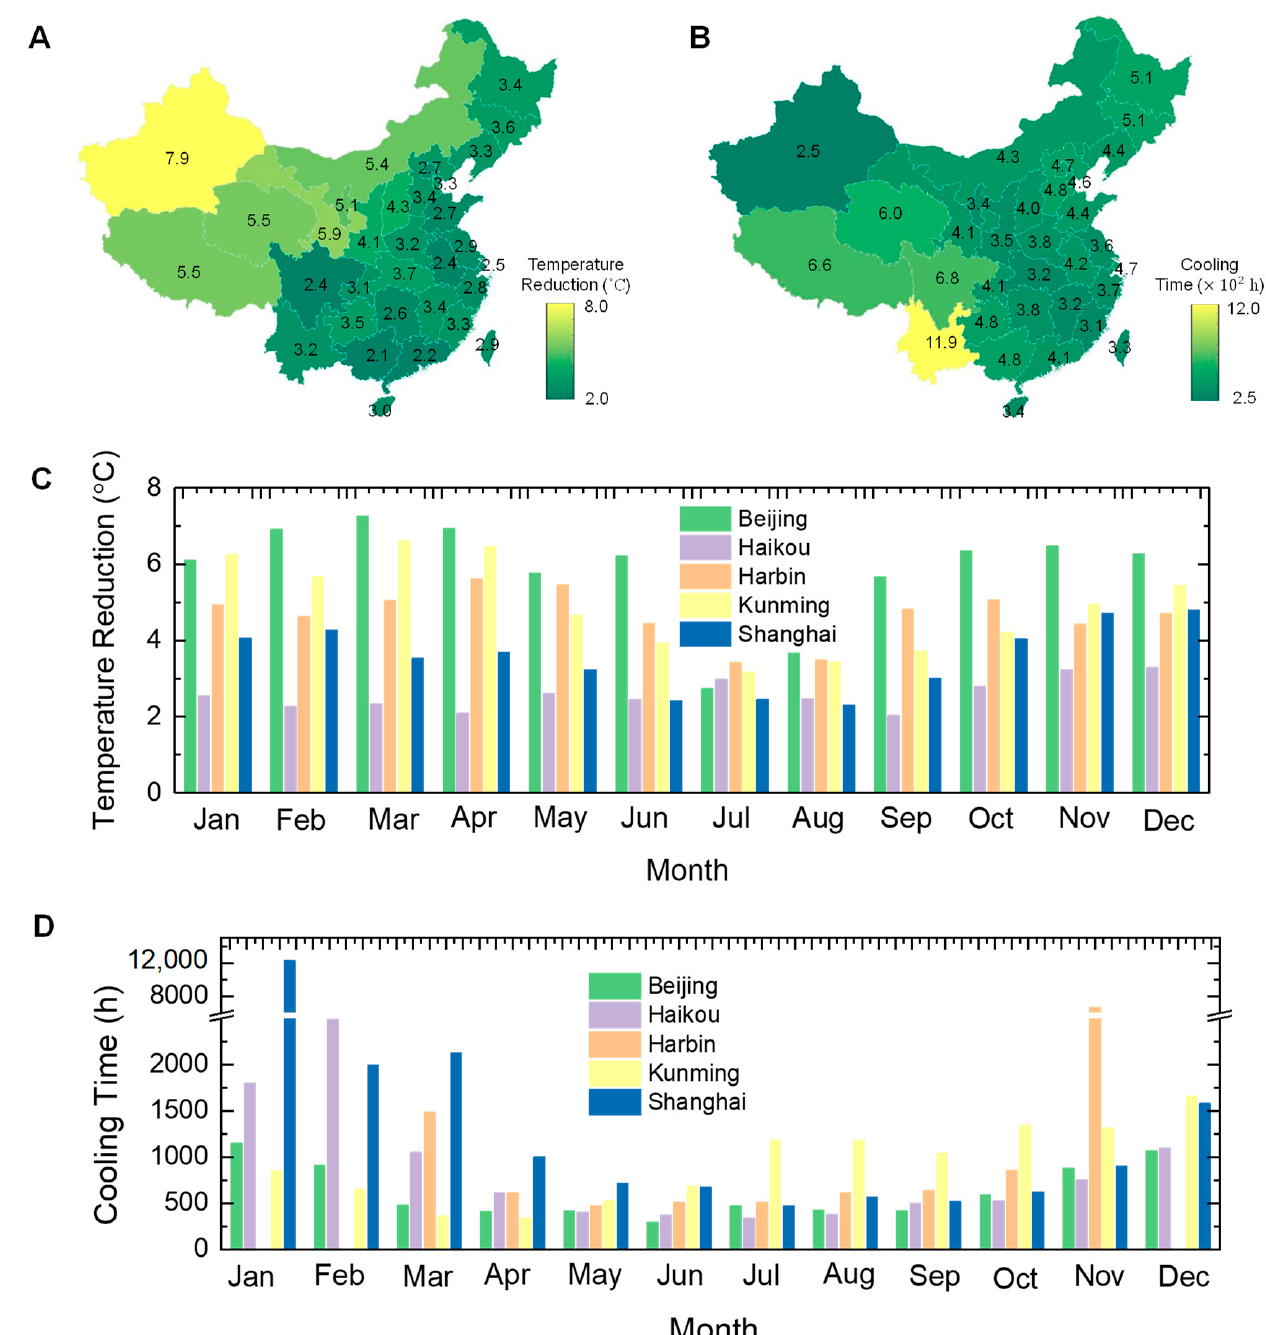
Figure 8. Cooling potential of the proposed bilayer structure in China. Simulated mean temperature reduction ( A ) and cooling time ( B ) in July. Simulated monthly temperature reduction ( C ) and cooling time ( D ) for different climate regions.